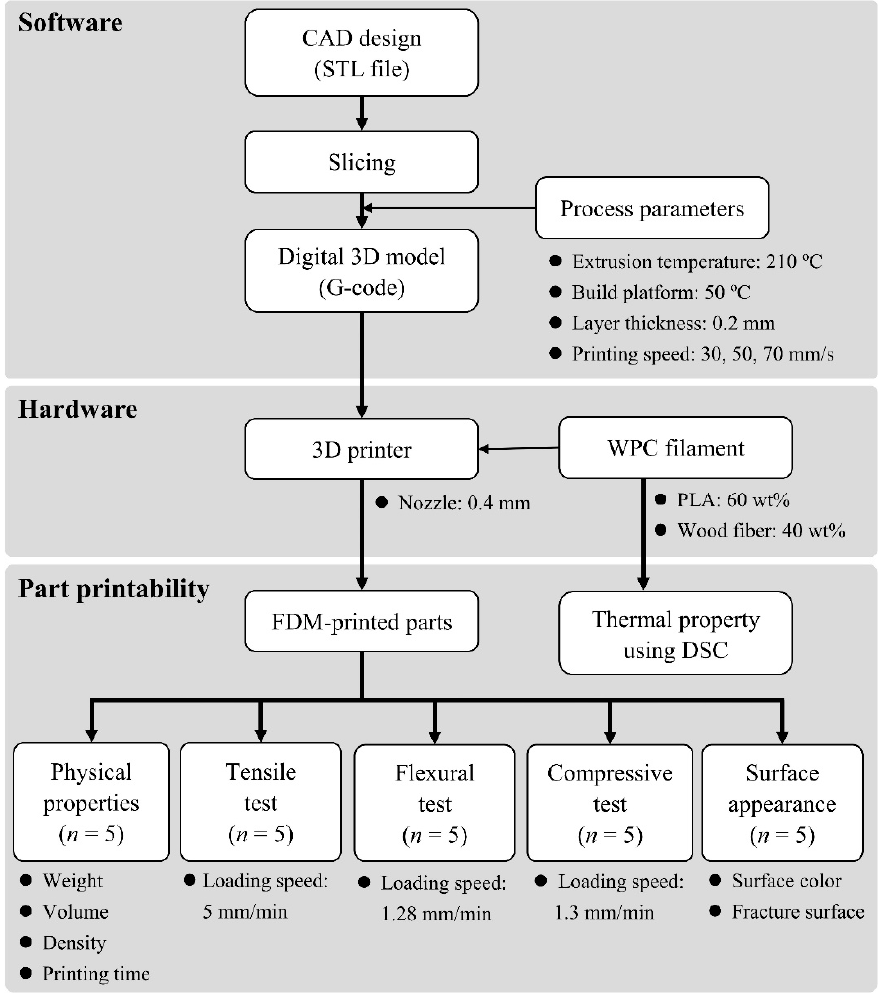
Figure 4. Work plan of the present study.